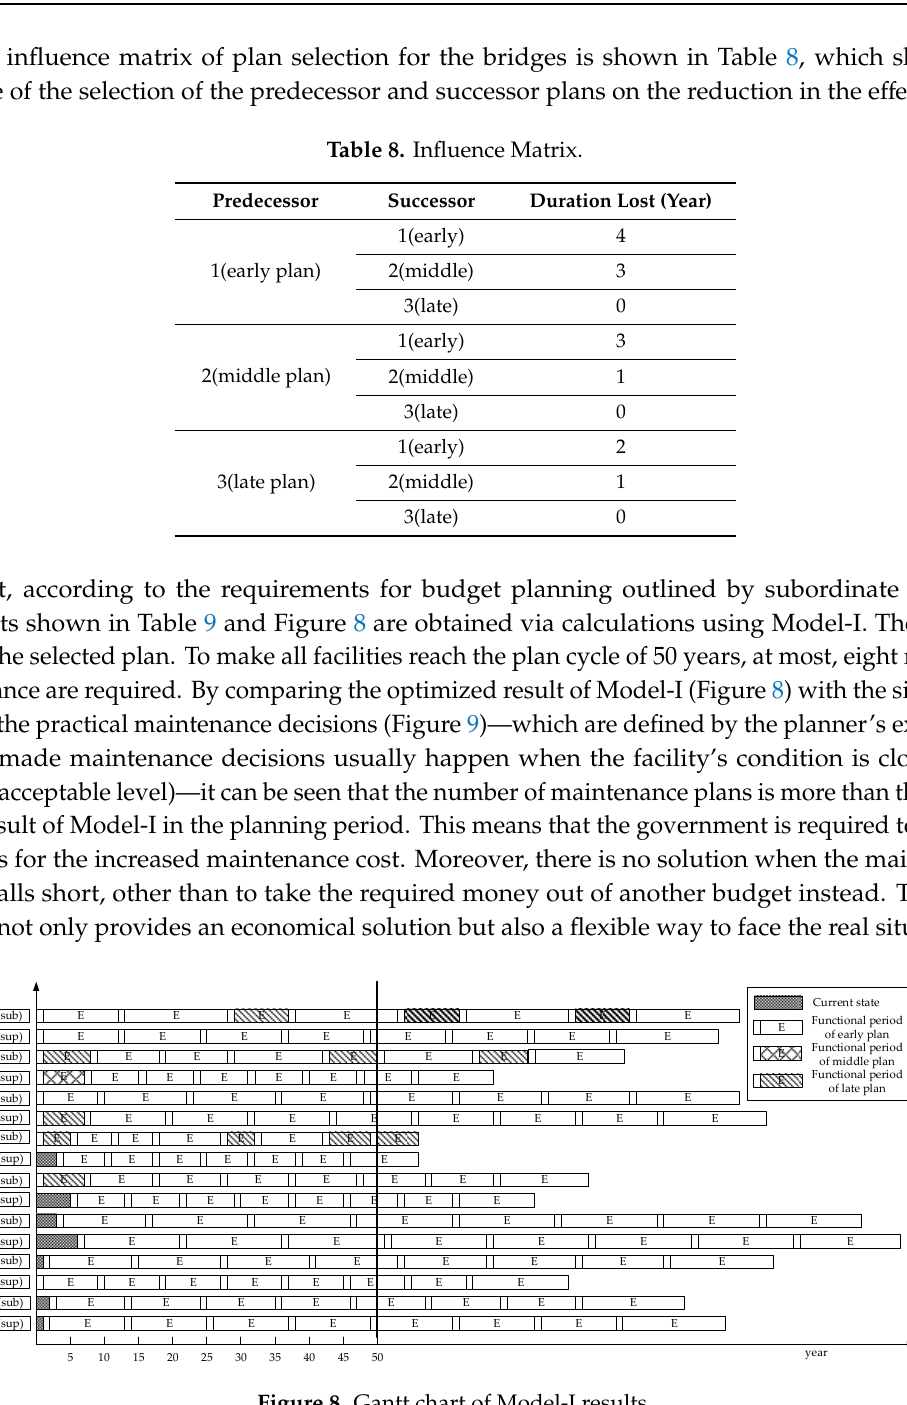
Figure 8. Gantt chart of Model-I results.